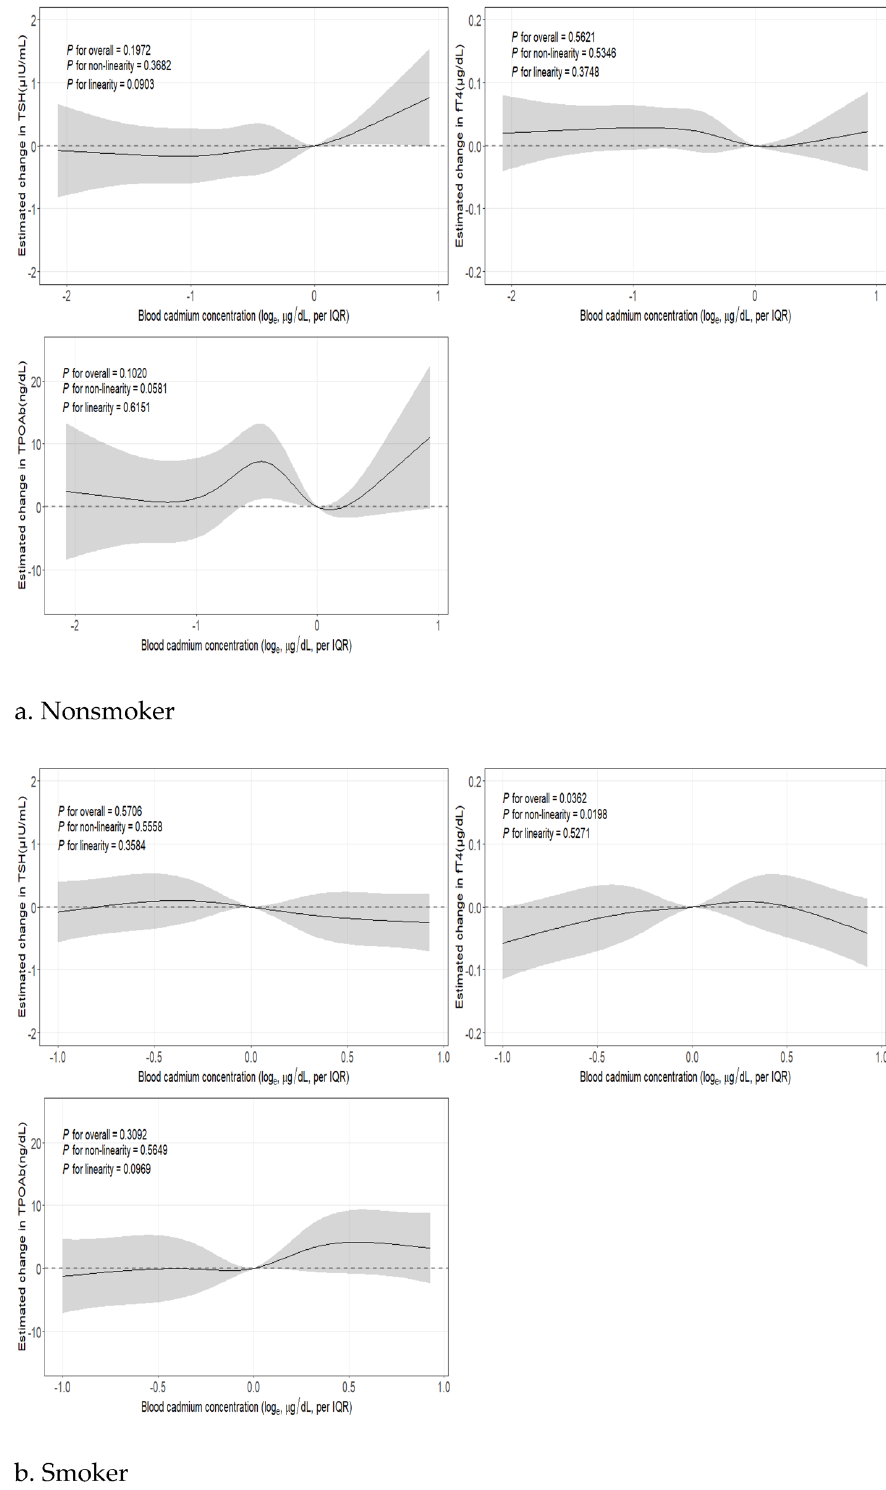
Figure 2. Nonlinear association between BCd and thyroid hormones (TSH, fT4, TPOAb) by smoking status a,b . a Adjusted for age, sex, education level, smoking status, marital status, household income, body mass index, alcohol consumption, blood lead, blood mercury, and urine iodine-to-creatinine ratio. b The solid lines show the fitted five-knot spline relationship using a referent 50th percentile of blood lead; the shaded parts indicate the 95%